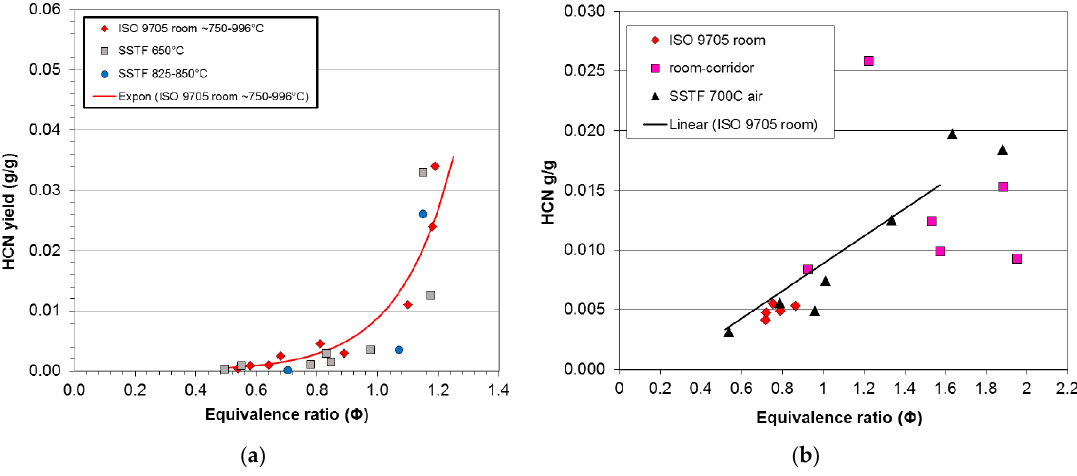
Figure 6. Data points for HCN yield (g/g) as a function of equivalence ratio ( Φ ) for two nitrogen-containing materials measured in compartment fire experiments compared to data points for the same or similar fuels measured in SSTF experiments. ( a ) Polyamide 6.6 and 6; ( b )